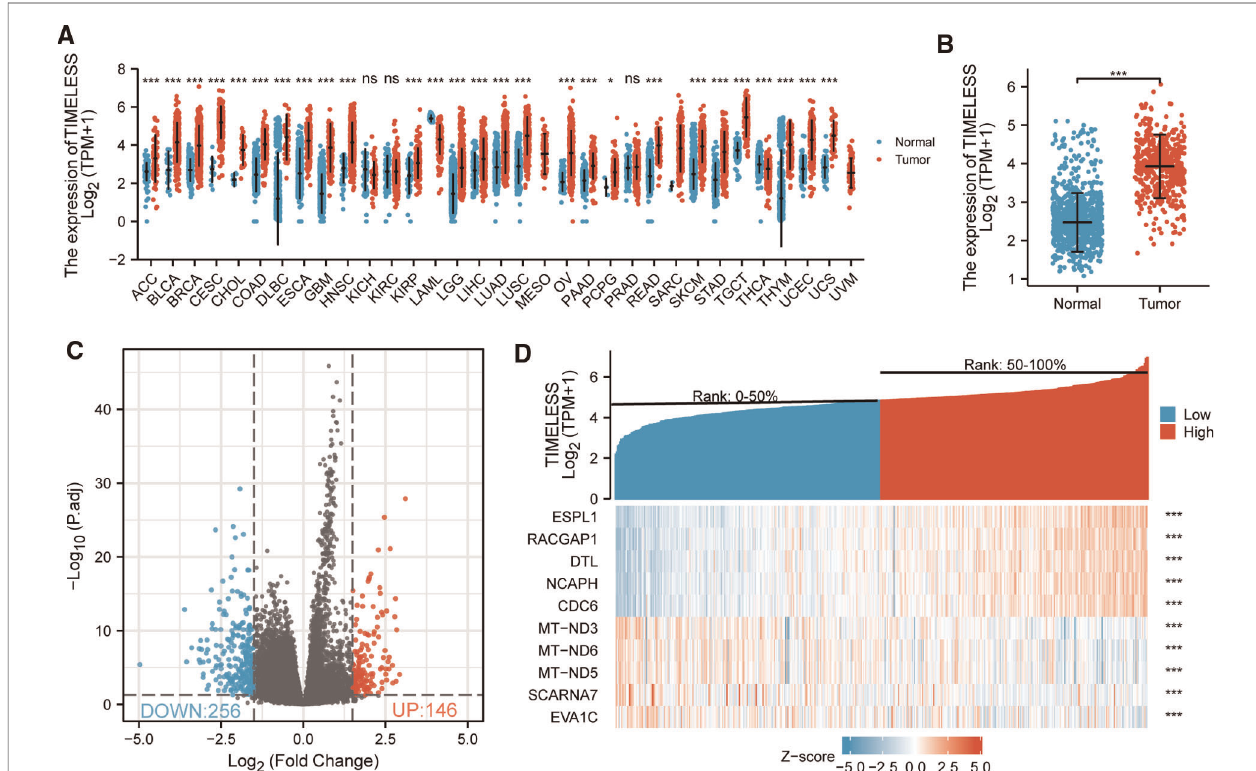
FIGURE 1 | Differential mRNA expression pro fi les in skin cutaneous melanoma (SKCM) patients strati fi ed by TIM levels. ( A ) The comparison of TIM expression between tumor and normal tissue in different malignancies based on TCGA database. ns, p ≥ 0.05; * p <0.05; ** p <0.01; *** p <0.001. ( B ) TIM expression was higher in SKCM tumors than normal skin tissue. Based on the median TIM level, 472 SKCM patients from TCGA-SKCM project were strati fi ed into high- and low-TIM expression groups. Shown were expression pro fi les of mRNA in the two subgroups; and data were presented by volcano plots ( C ) and heatmaps ( D